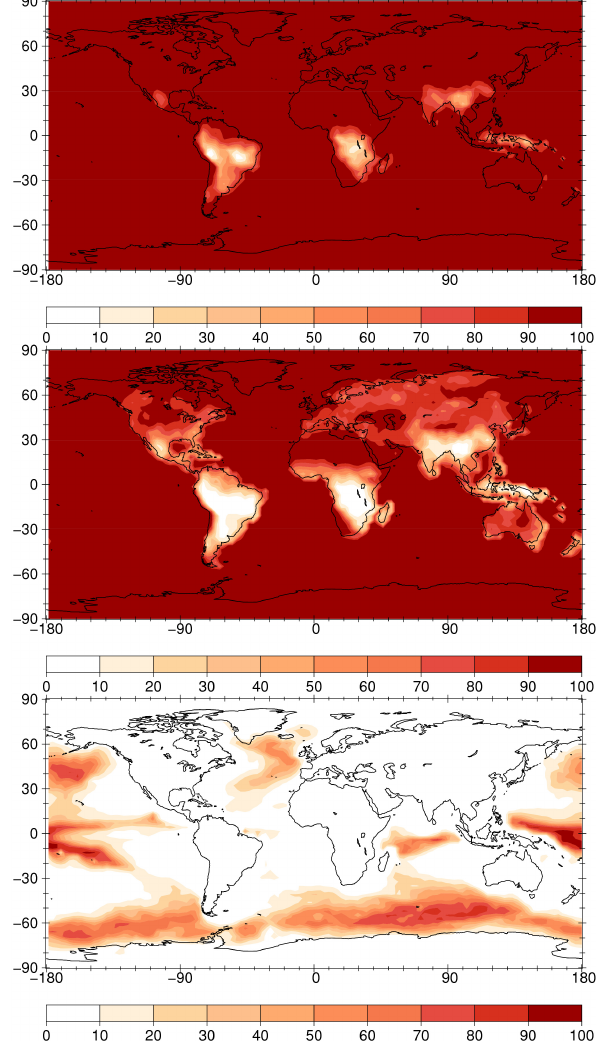
Fig. 8. Estimated percent of biogenic IN, active at − 15 ◦ C, from a marine source, relative to the total population of biogenic IN (from continental and marine sources). Top: “high” biogenic IN. Middle: “best” biogenic IN. Bottom: “low” biogenic